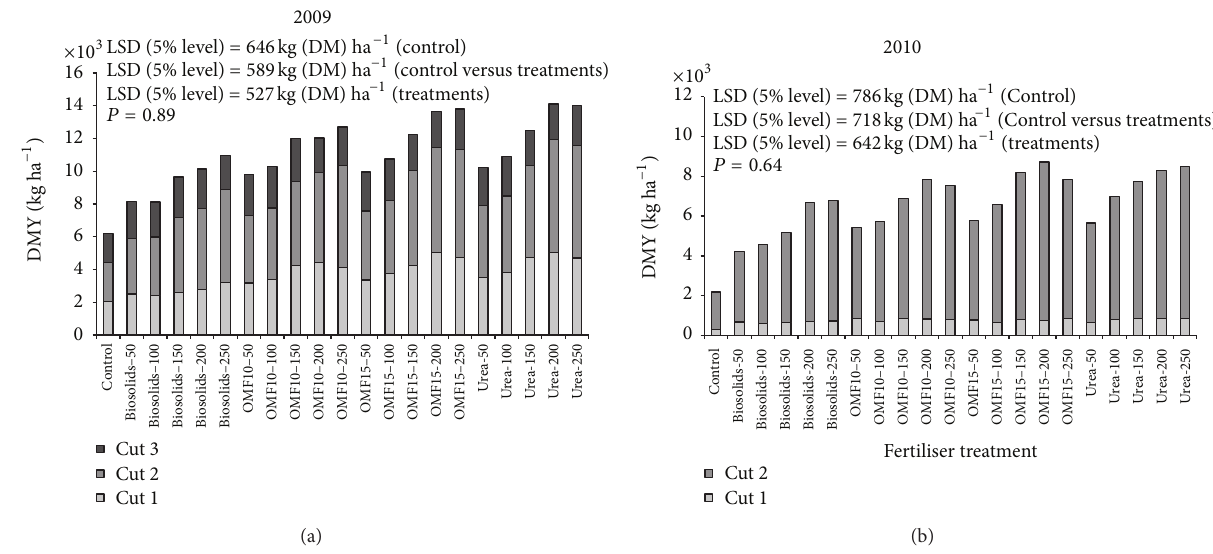
Figure 2: Dry matter yield (DMY) of the grass crop as affected by the fertiliser treatment in 2009 (a) and 2010 (b). The 𝑥 -axis shows the fertiliser type followed by the corresponding N application rate in kg per ha. Use 𝑛 = 4 (control) and 𝑛 = 3 (treatments) except when N = 250 kg ha −1 , 𝑛 = 2 .